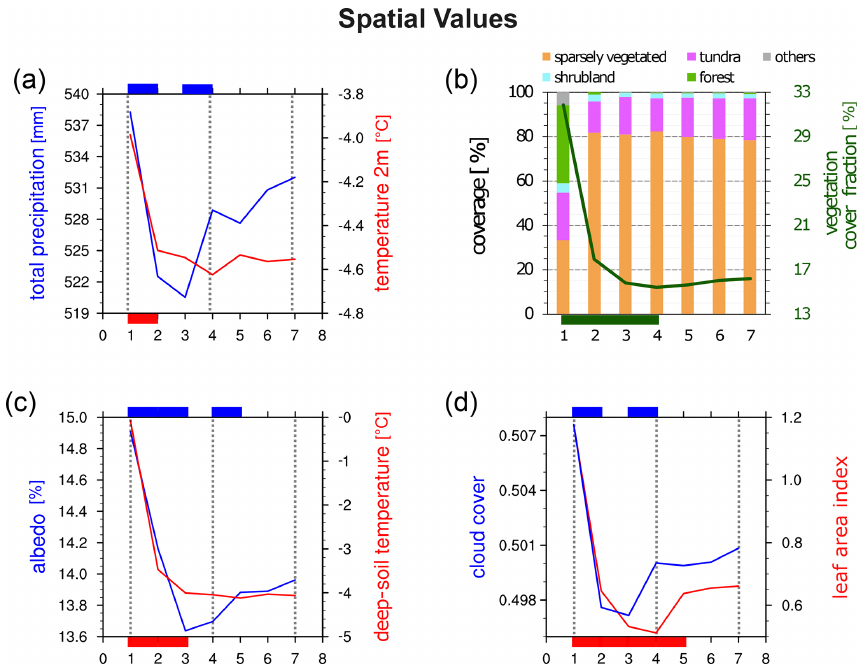
Figure 3. Thirty-year spatial climatology of annual mean values throughout the iterations. Panel (a) represents total precipitation (blue line) and temperature at 2m (red line) and (b) the percentage spatial fraction of bare (orange), tundra (pink), shrubland (sky blue), forest (light green), others (grey), and the spatial mean value of vegetation cover fraction (dark green line); (c) is the same as (a) but for albedo and deep-soil temperature, and (d) is the same as (a) but for cloud cover and leaf area index. The grey dotted lines in (a) , (c) , and (d) represent the first, fourth, and seventh iterations. Blue, red, and green boxes represent statistically significant differences between iterations at a 2% significance level (using a two-tailed bootstrapping